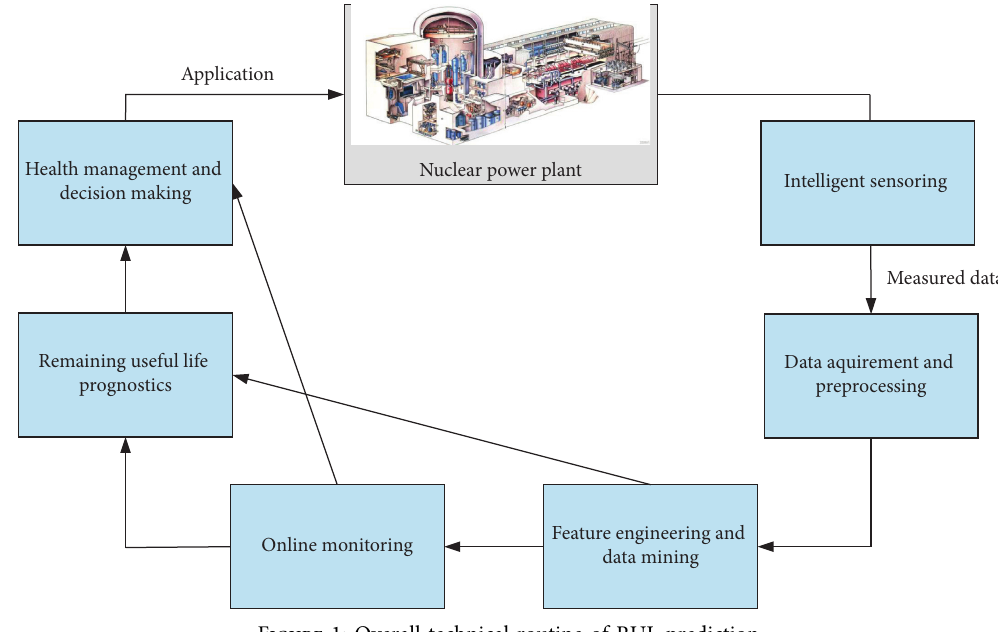
Figure 1: Overall technical routine of RUL prediction.